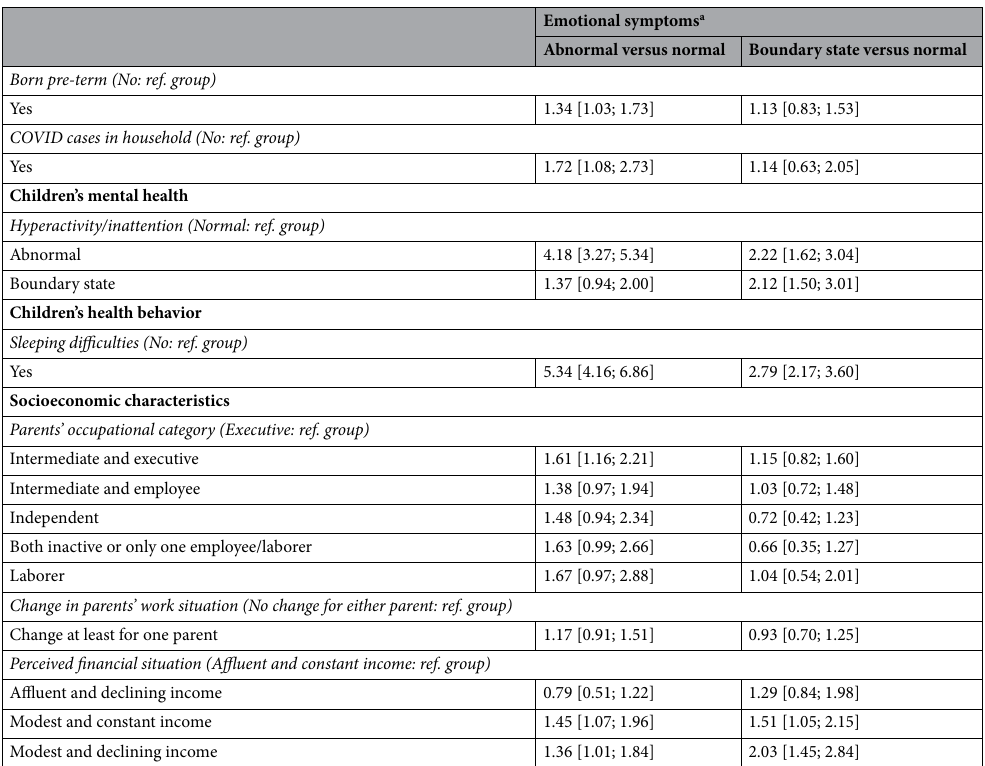
Table 6. Associations between most predictive factors from elastic net selection and emotional symptoms: multivariate multinomial logistic regressions (n = 5097). a Adjusted on prematurity, COVID cases in household, hyperactivity/inattention symptoms, sleeping difficulties, parents’ occupational category, change in parents’ work situation and perceived financial